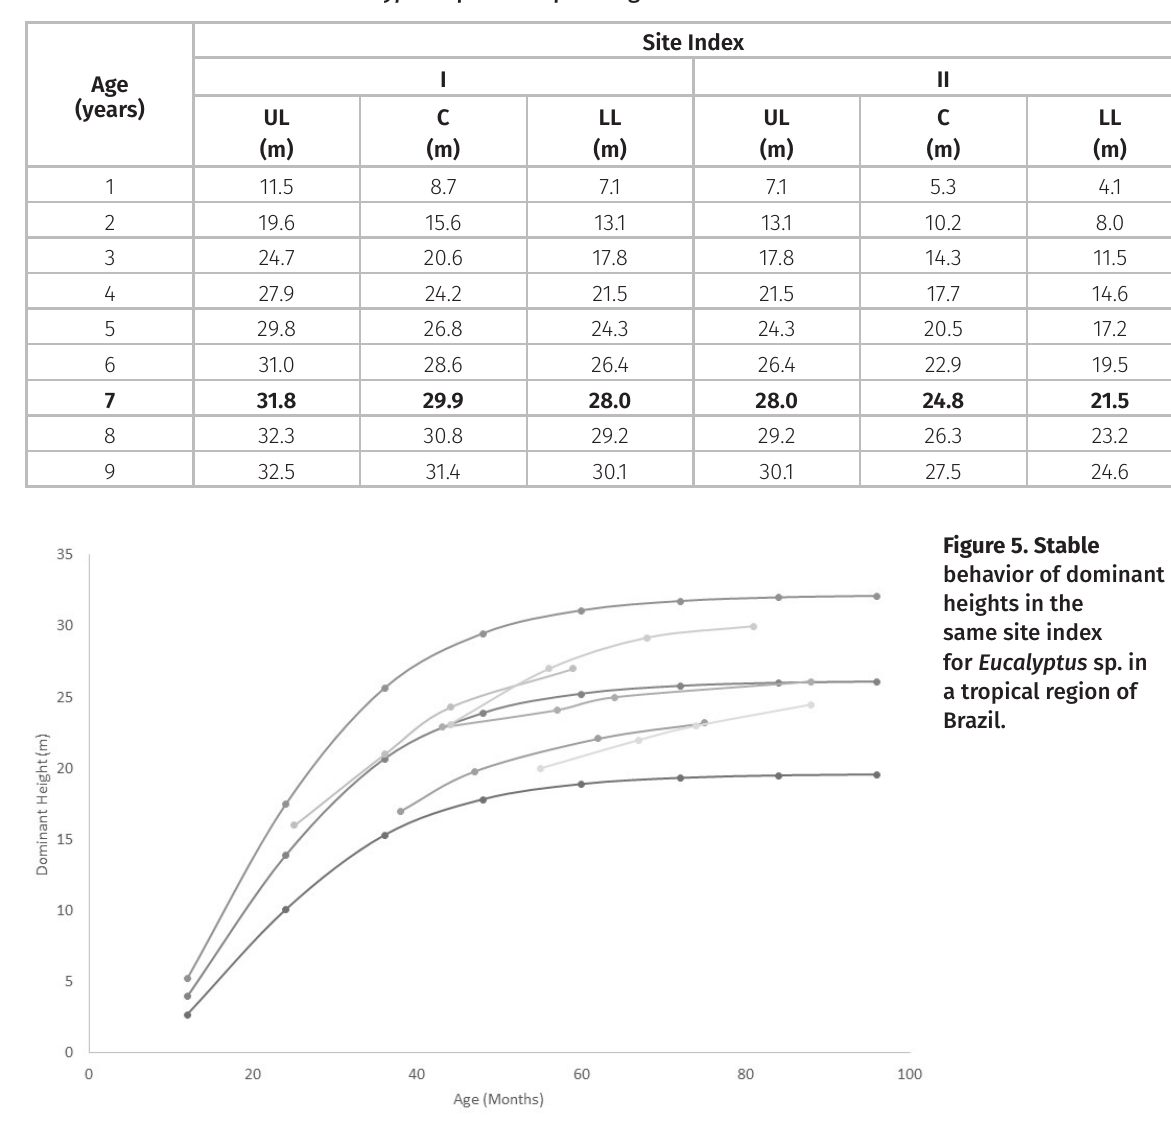
Table III. Site Index values for Eucalyptus sp. in a tropical region of Brazil.